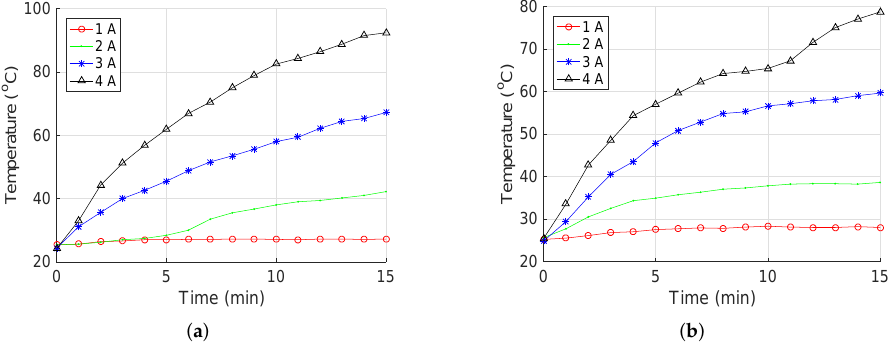
Figure 6. Relationship between the temperature for the electromagnetic coils along ( a ) x-axis or y-axis, and ( b ) z-axis versus time under 1 Hz sinusoidal current